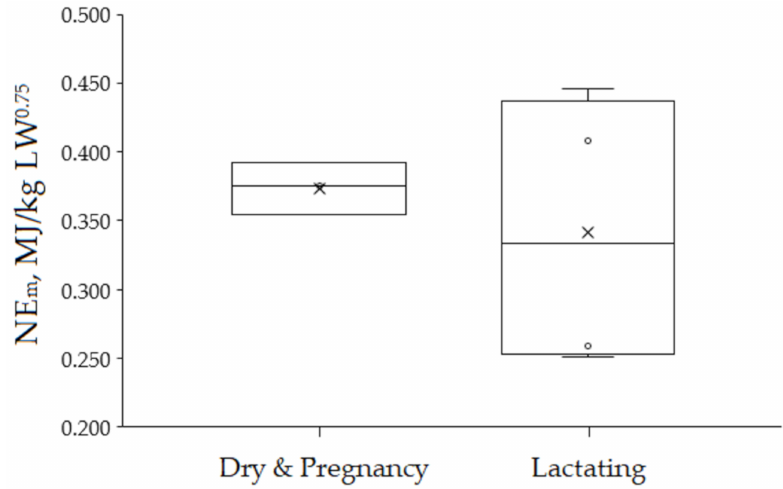
Figure 5. Boxplots of energy requirements for maintenance (NE m ) summarizing data from studies conducted with suckler cows at two physiological stages (mostly Bos taurus animals). The values reported in the following studies were taken for obtaining this plot: dry and pregnant cows [65,69]; lactating cows: